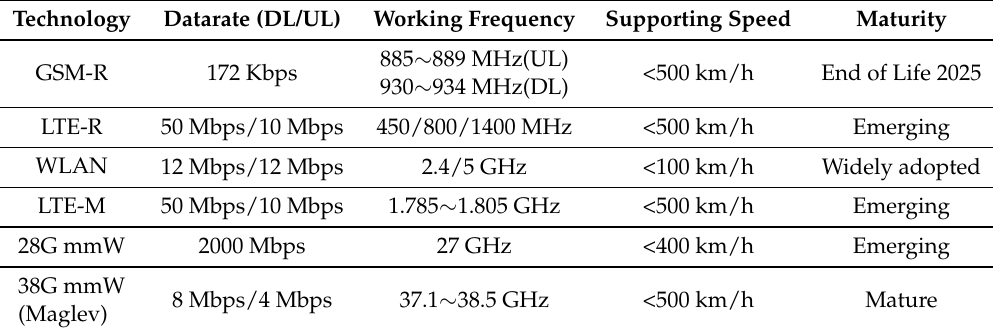
Table 1. Applied wireless technologies in railway